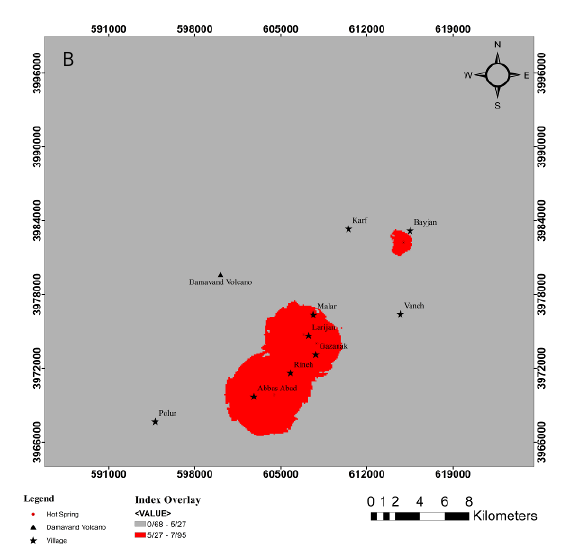
Figure 9. A) The result of Index overlay. B) The result of Index Overlay after applying (µ+2σ)